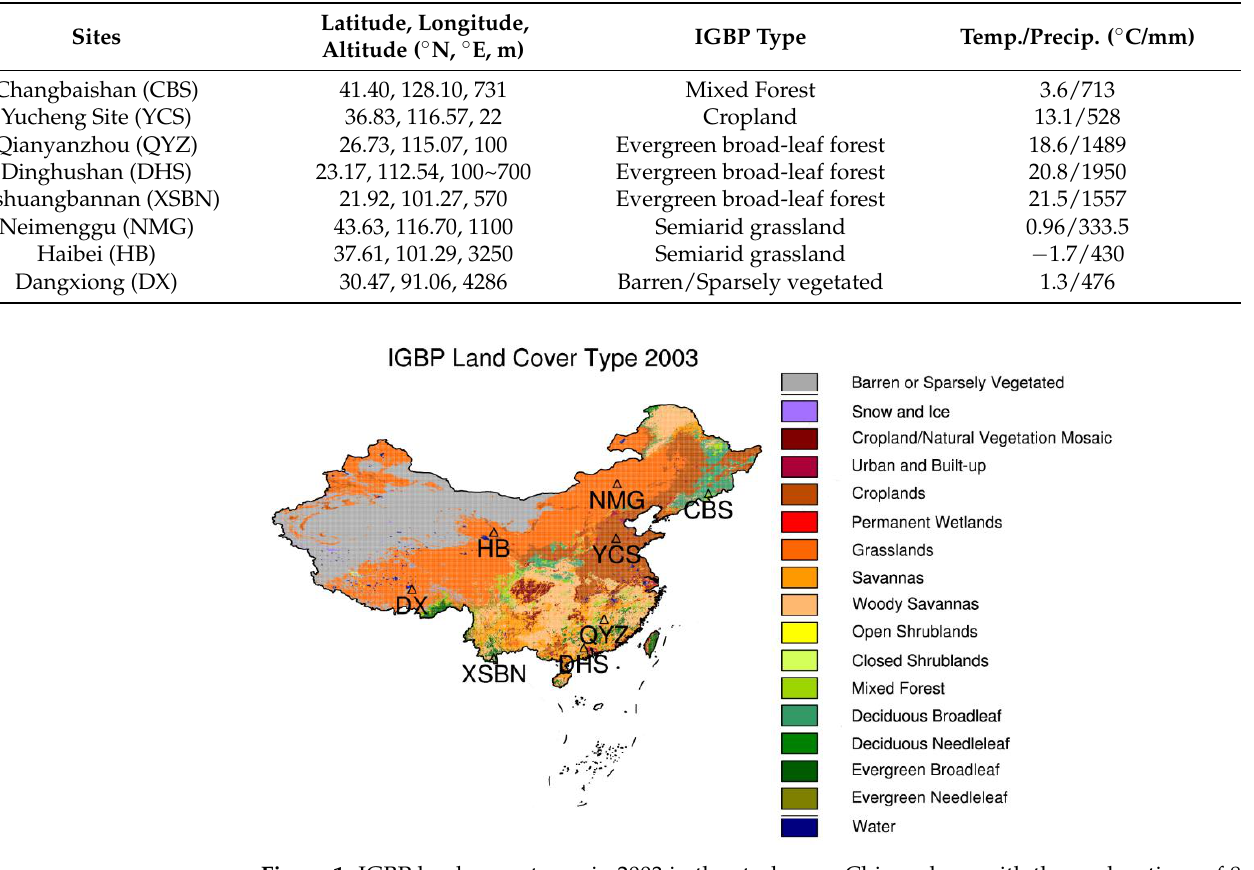
Figure 1. IGBP land cover types in 2003 in the study area China, along with the geolocations of 8 ChinaFlux sites.